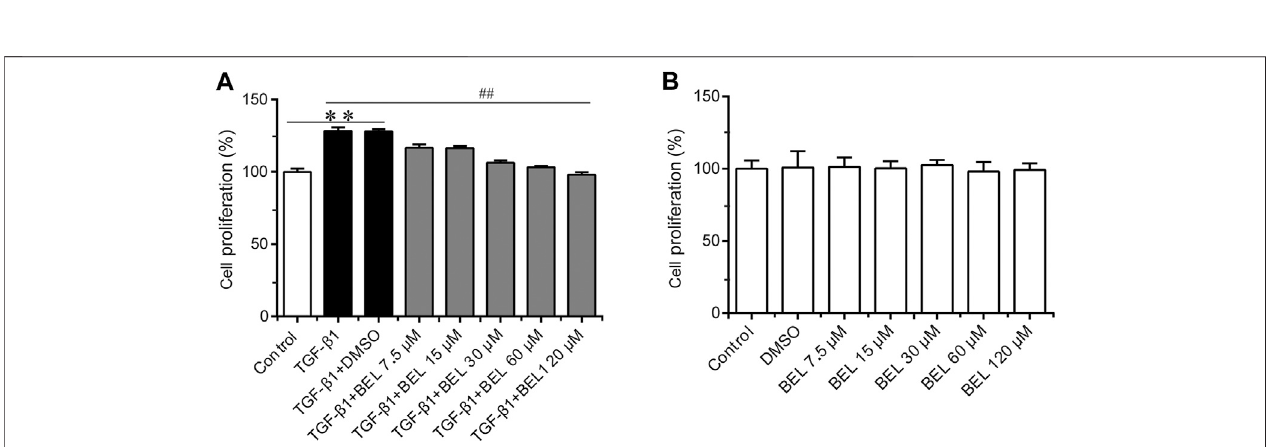
FIGURE3| Theeffects ofBELonCFsproliferationinthepresenceorabsenceofTGF- β 1 (A) TheeffectsofdifferentdosesofBEL(7.5,15,30,60,and120 μ M) on the proliferation of CFs induced by TGF- β 1 using CCK-8 kit (B) The effects of different doses of BEL (7.5, 15, 30, 60, and 120 μ M) on the viability of CFs without TGF- β 1 stimulation using CCK-8 kit. Data were shown as mean ± SEM. ** p < 0.01 vs. control, ## p < 0.01 vs. TGF- β 1.